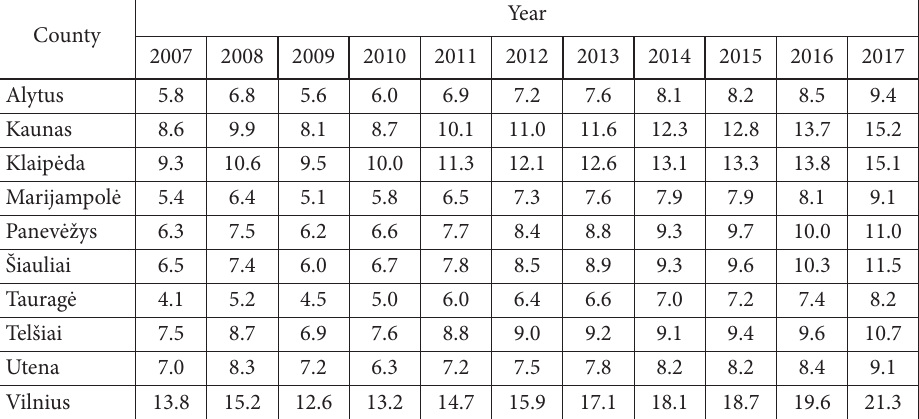
Table 2. GDP per capita at current prices in Lithuanian counties in thousands EUR (source: Statistics Lithuania, n.d.) County